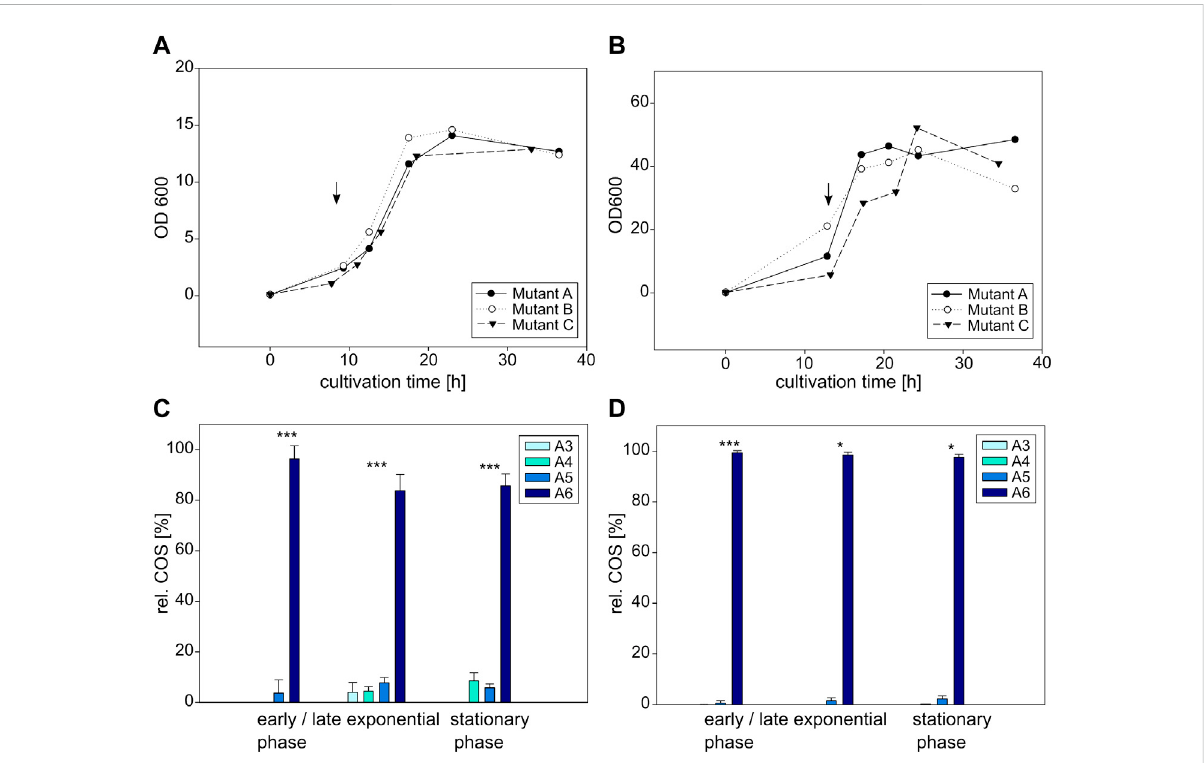
FIGURE 7 Cultivation and COS production of E coli BL21 (left) and C glutamicum (right) expressing the NodC_R346S mutein. Depicted is the growth of E. coli (A) and C. glutamicum (B) in triplicates as well as their product composition (C,D) . The time of induction is denoted with an arrow. MS signals were converted into molar fractions and are shown as shares of the total amount of product, namely the relative amount of fully acetylated trimer (A3) to hexamer (A6) for E. coli (C) and C. glutamicum (D) . The asterisks inC and D indicate thesigni fi cance level for the difference between the product compositions in the same cultivation phase for E. coli between NodC_GRH2 wildtype (Figure 5C) and R346S (Figure 7C) and for C. glutamicum between NodC_GRH2 wildtype (Figure 5D) and R346S (Figure 7D) determined with an independent samples t -test.